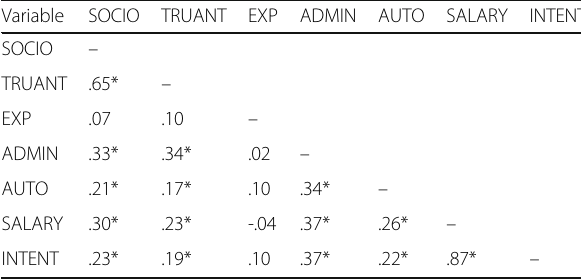
Table 3 Correlations among variables for the measurement model Variable SOCIO TRUANT EXP ADMIN AUTO SALARY